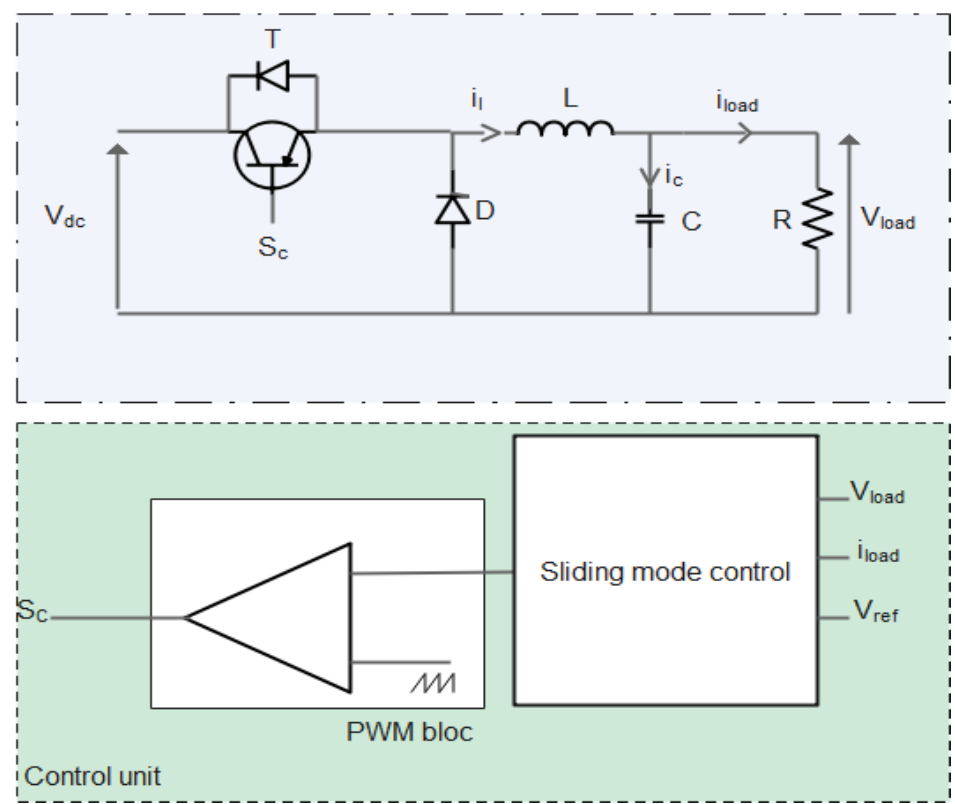
Figure 6. Closed loop control of buck control using sliding mode control approach.